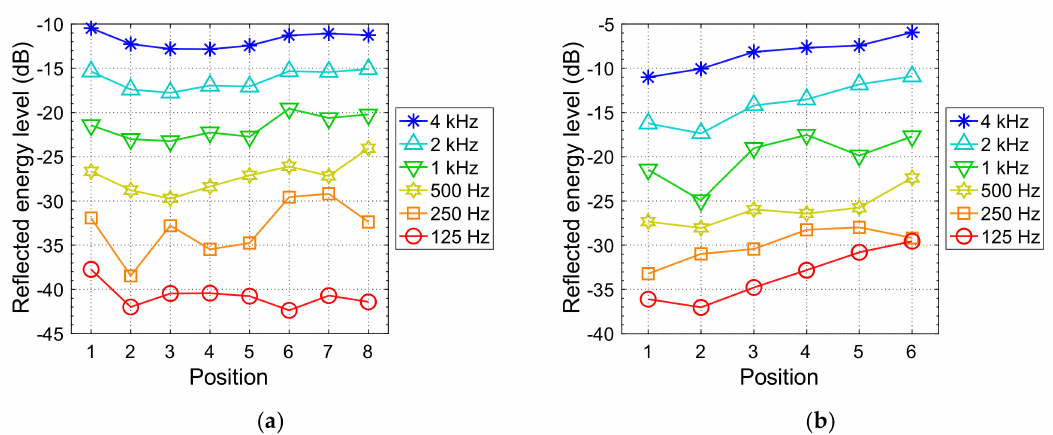
Figure 6. Retroreflected octave-band energy levels returned to the source position predicted by Equation (2): ( a ) Panna Meena ka Kund (full model); ( b ) Lahan Vav. Values are expressed relative to the emitted free field energy at 1